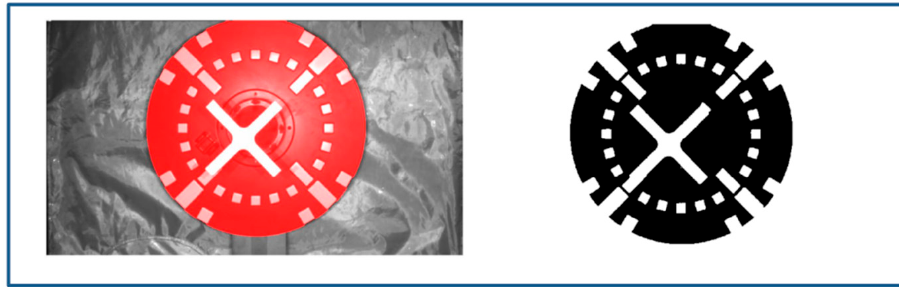
Figure 14. Dataset mask and GT.